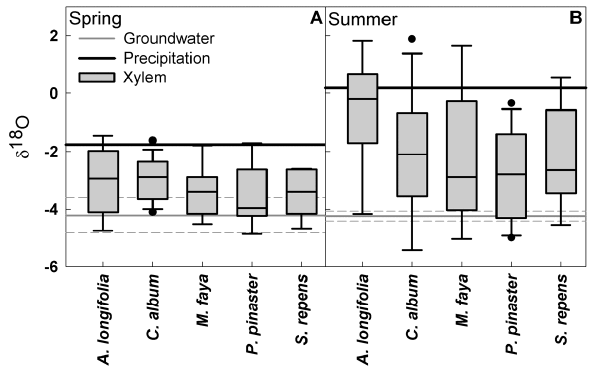
Fig. 3. δ 18 O (‰) of xylem water (boxplot), precipitation (black line) and groundwater (grey line) in (A) spring (May) and (B) summer (August). Boxplots denote the 10th, 25th, median, 75th and 90th percentiles of the xylem δ 18 O for each species. Out- lying values are indicated by solid circles denoting the 5th and 95th percentiles. Precipitation δ 18 O for spring is the mean value of the two major rainfall events during May 2005 (12–13 May, δ 18 O = –1.8‰; 25 May, δ 18 O = –1.7‰). There was very little measurable precipitation in August and therefore a long-term mean value of 0.18‰ was used for summer precipitation. Groundwater δ 18 O values are denoted as the monthly mean (solid grey line) ± SD (dotted grey lines) of groundwater collected approximately monthly from 2002 through 2006.